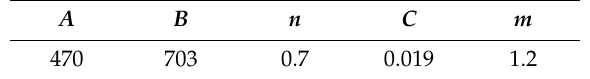
Table 2. Parameters for the rate-dependent elastic-plastic material.